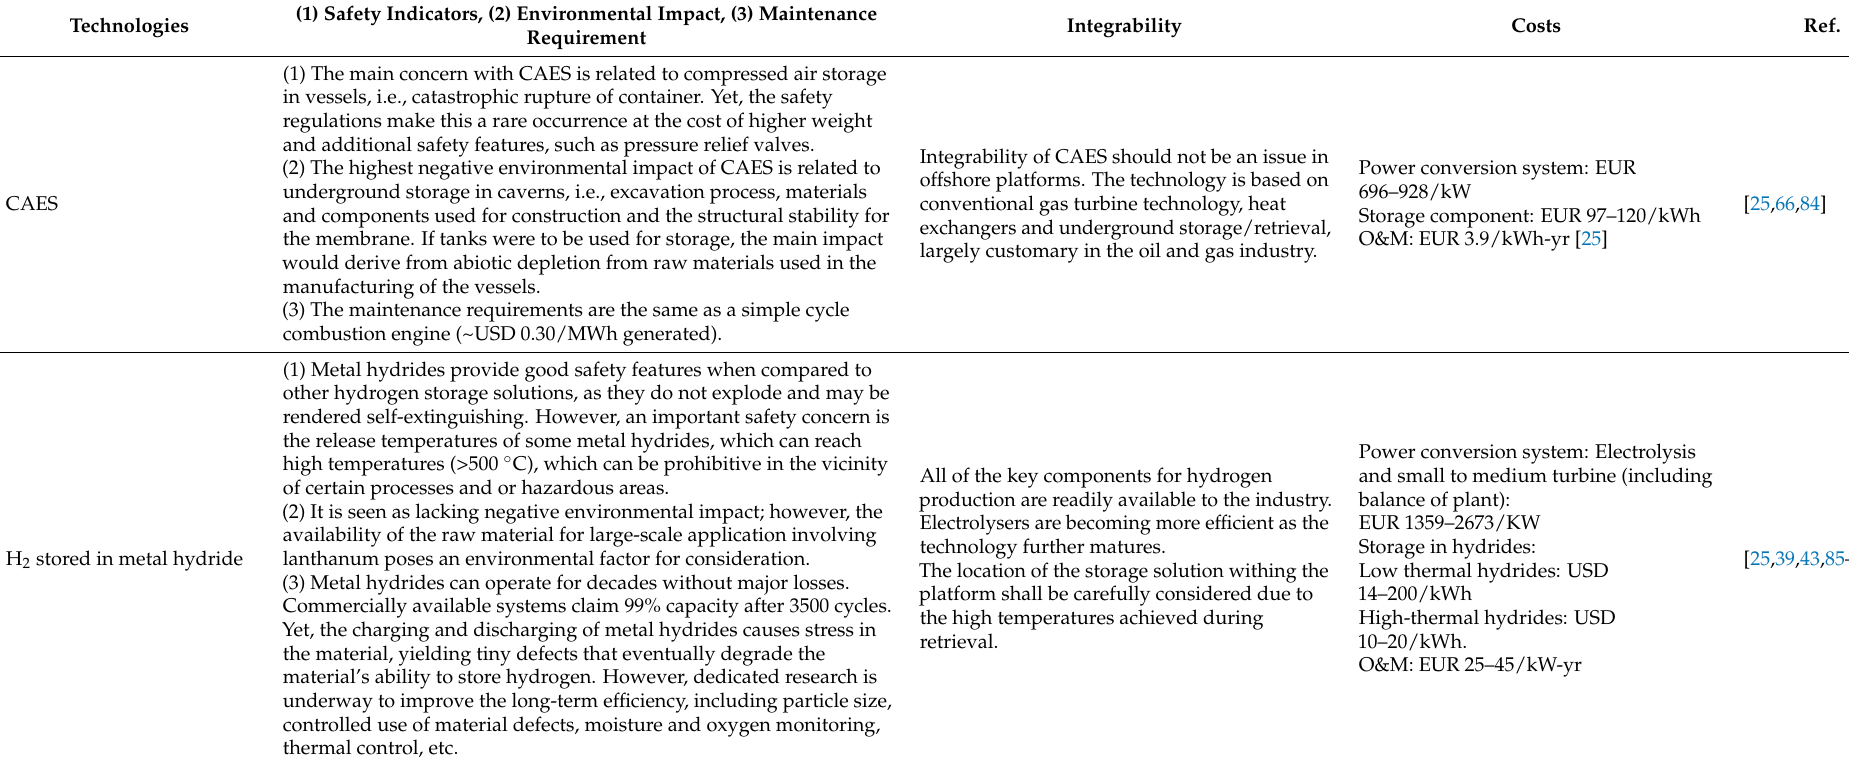
Table A8. Information on safety, environmental impact, integrability and costs of energy storage